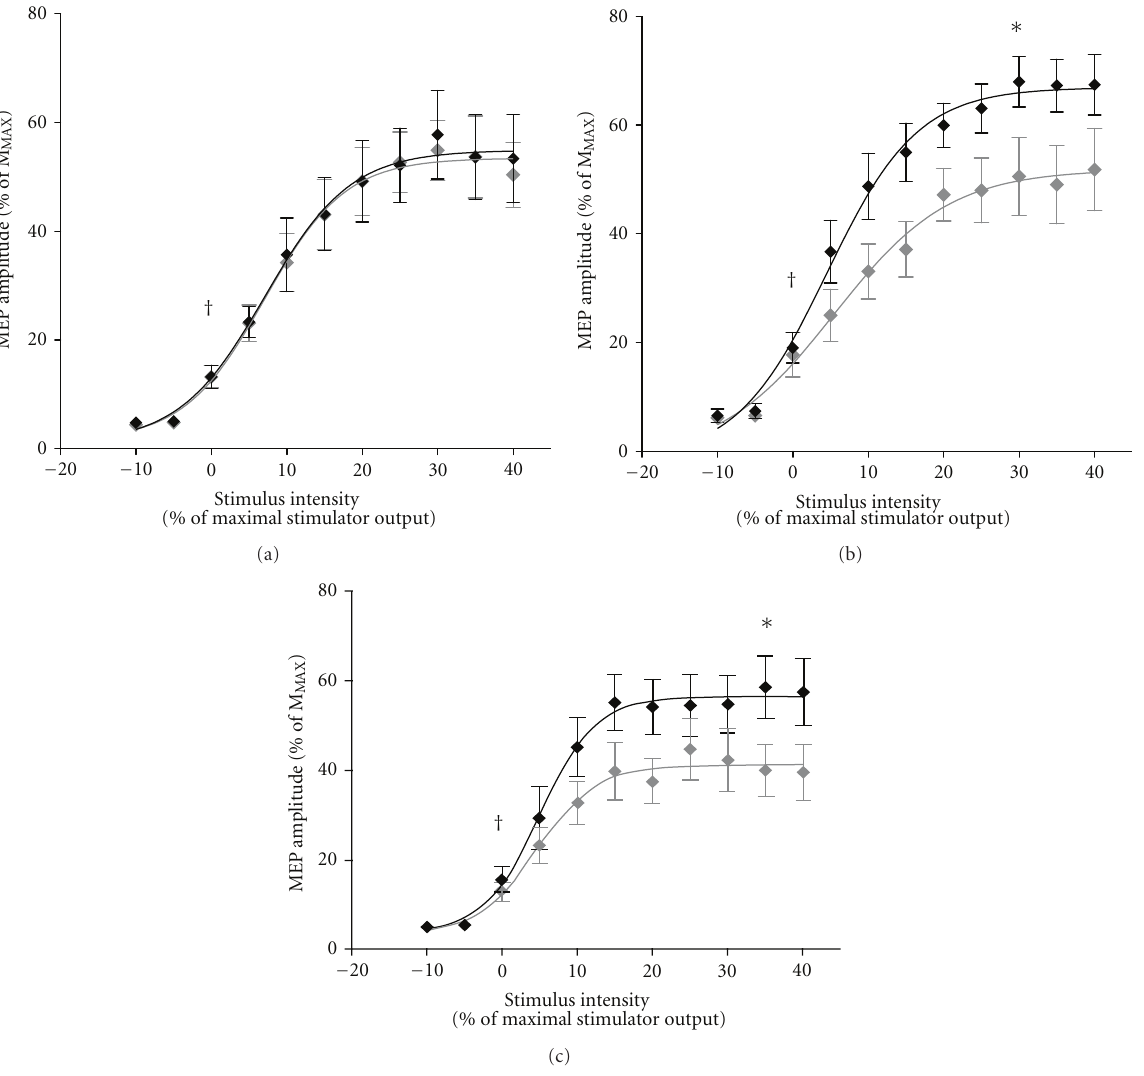
Figure 3: Mean ± SE MEP amplitudes (expressed as a percentage of M MAX ) obtained from the left untrained rectus femoris for the control (a), ST (b), and ST + V (c) groups before (light curve) and after (dark curve) training. Each recruitment curve is characterised by AMT, estimated slope and peak height (plateau), and the stimulus intensity at which the MEP amplitude is 50% of the maximum MEP ( V 50 ). † identifies AMT. ∗ denotes significant increases in peak height post training ( P < 0 . 016). There were no di ff erences in peak height between the ST and ST + V groups following training ( P = 1 .